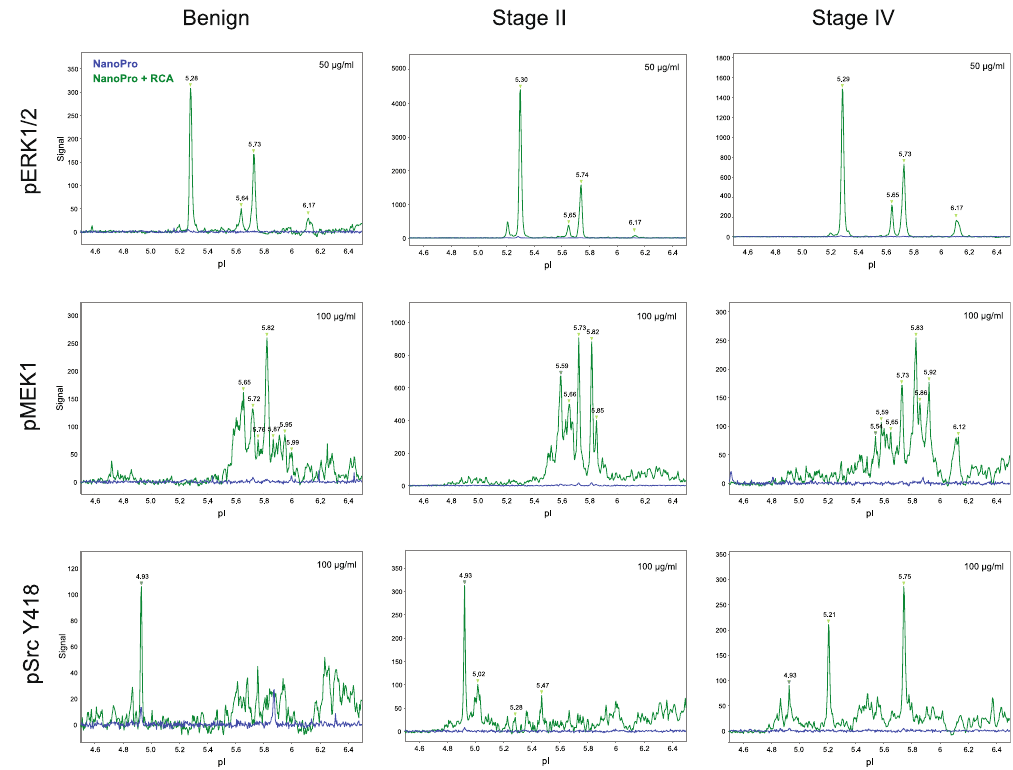
Figure 4. Detection of signal transducers in colorectal cancer samples. Visualization of pERK1/2 (top), pMEK1 (middle) and pSrc Y418 (bottom) in human colorectal cancer samples from patients at different stages of the disease. Detailed overlay graphs of protein detection with standard NanoPro assay (blue) and NanoPro + RCA (green) are